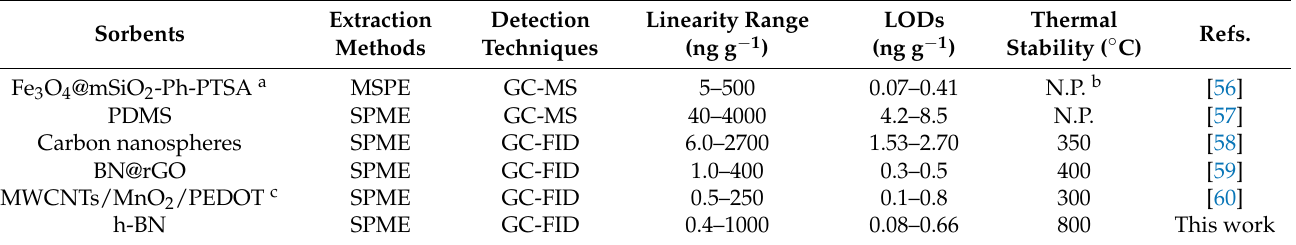
Table 4. Comparison of the proposed method with other reported techniques for determination of PAHs in